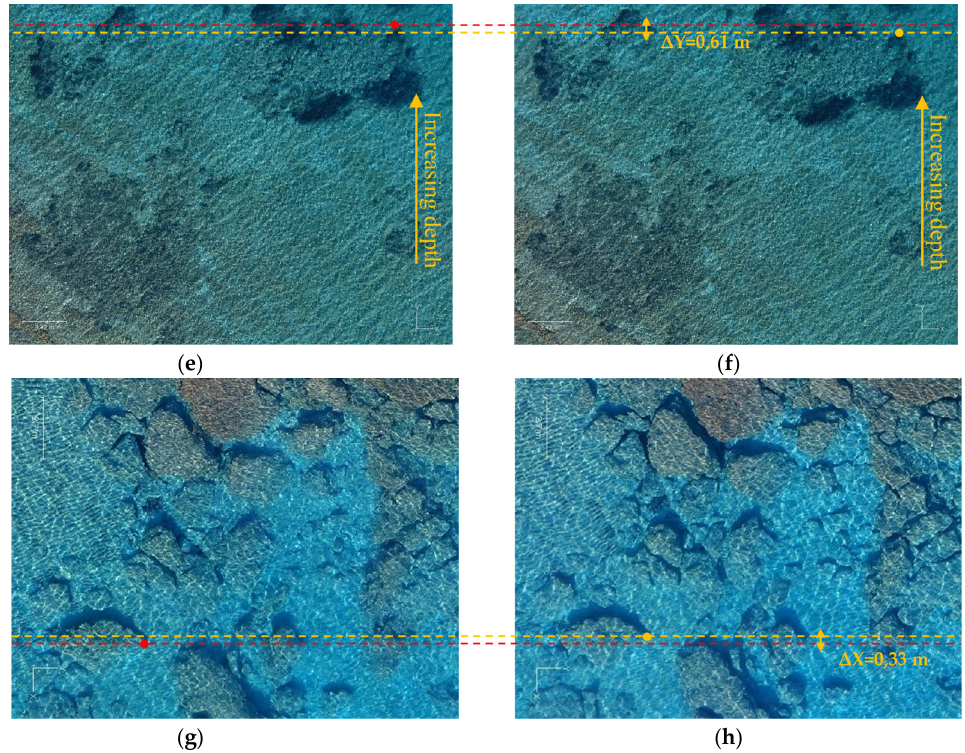
Figure 10. Parts of the orthoimages of Amathounta ( a , b ), Agia Napa ( c , d ), Cyclades-1 ( e , f ), and Cyclades-2 ( g , h ) test sites. In the left column, the orthoimages generated using the uncorrected imagery are presented, while in the right column, the results using the refraction corrected imagery are presented.